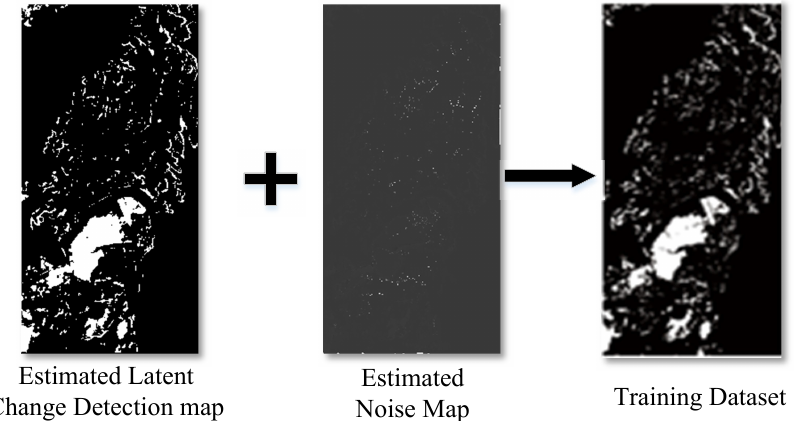
Figure 9. Illustration of the learned latent change detection map and the estimated noise map. The denoising module separates the training dataset into the latent change detection map and the noise